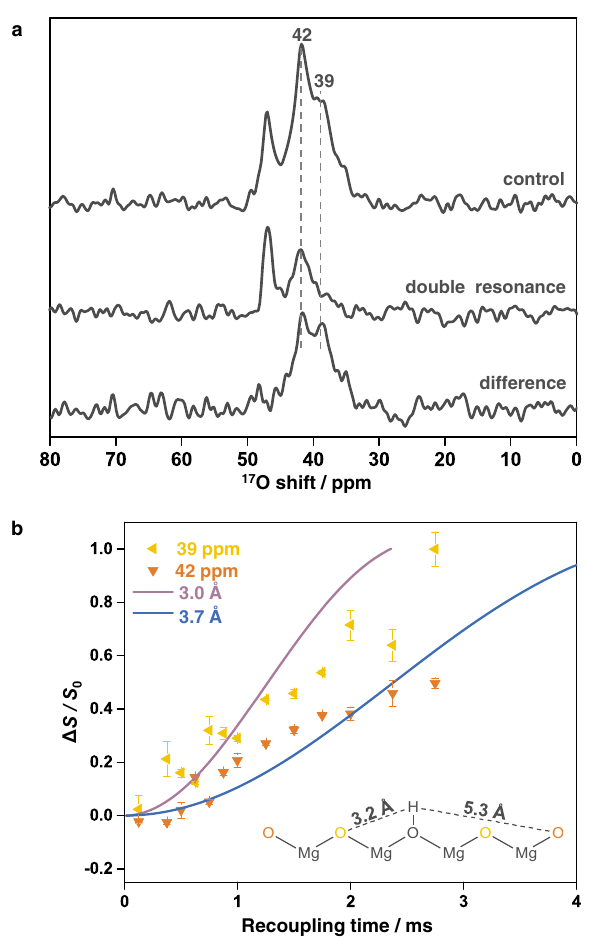
Fig. 3 17 O- 1 H REDOR NMR data of MgO nanosheets (NS-773). a REDOR NMR spectra with a recoupling time of 2.75 ms. b REDOR fraction ( Δ S / S 0 ) as a function of recoupling time with the schematic surface structure of MgO. The yellow and orange triangles represent 39 and 42 ppm, respectively. External fi eld: 18.8 T; MAS rate: 16 kHz; recycle delay: 5 s.